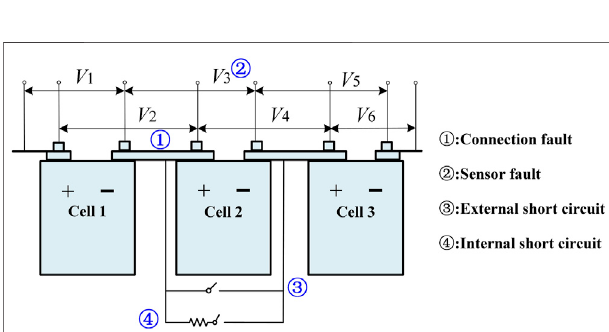
FIGURE 4 | Schematics of multi-fault occurs in the series connected battery